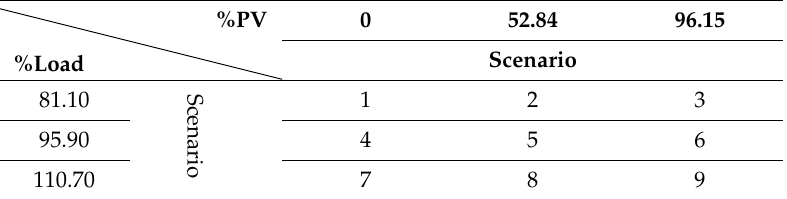
Table 1. Composition of the scenarios, load and PV generation percentage for each period.